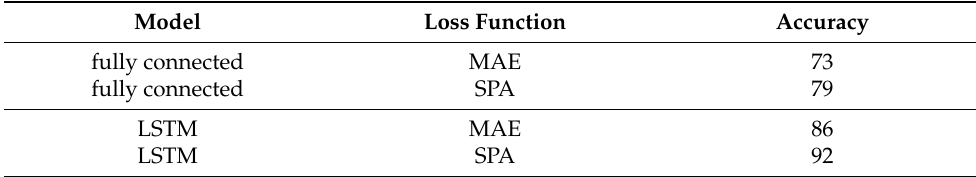
Table 2. Summary of performance of model types and loss functions. MAE stands for mean absolute error and SPA for smallest principal angle .